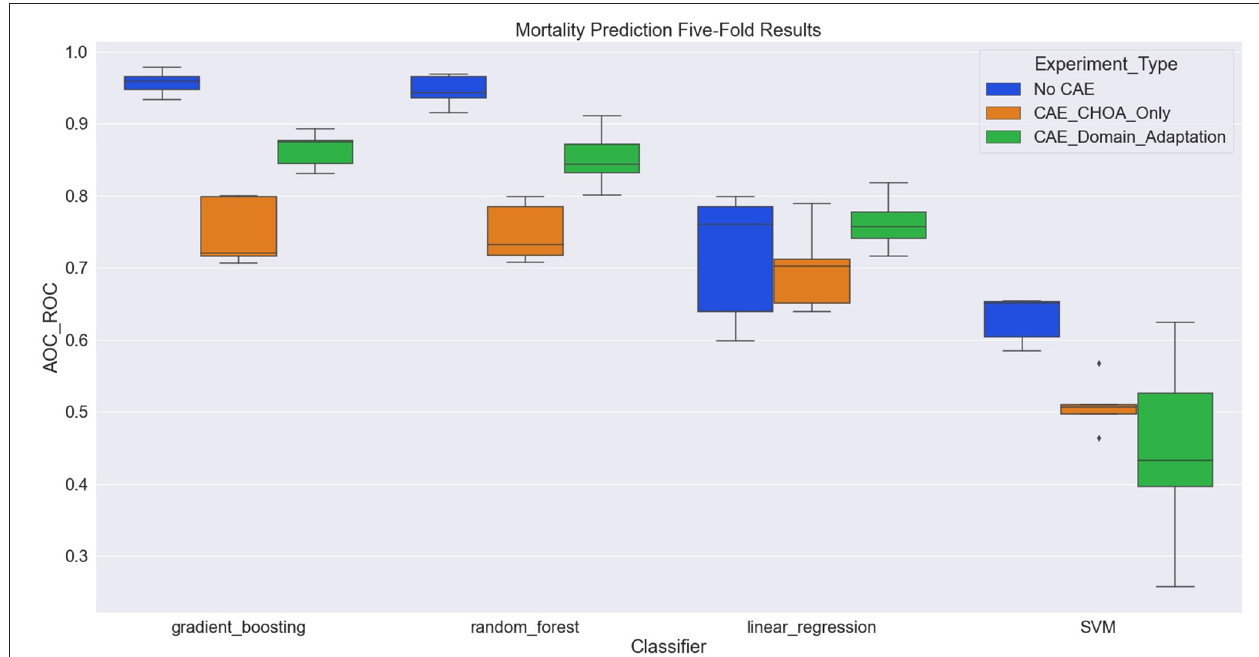
Frontiers in Artificial Intelligence |